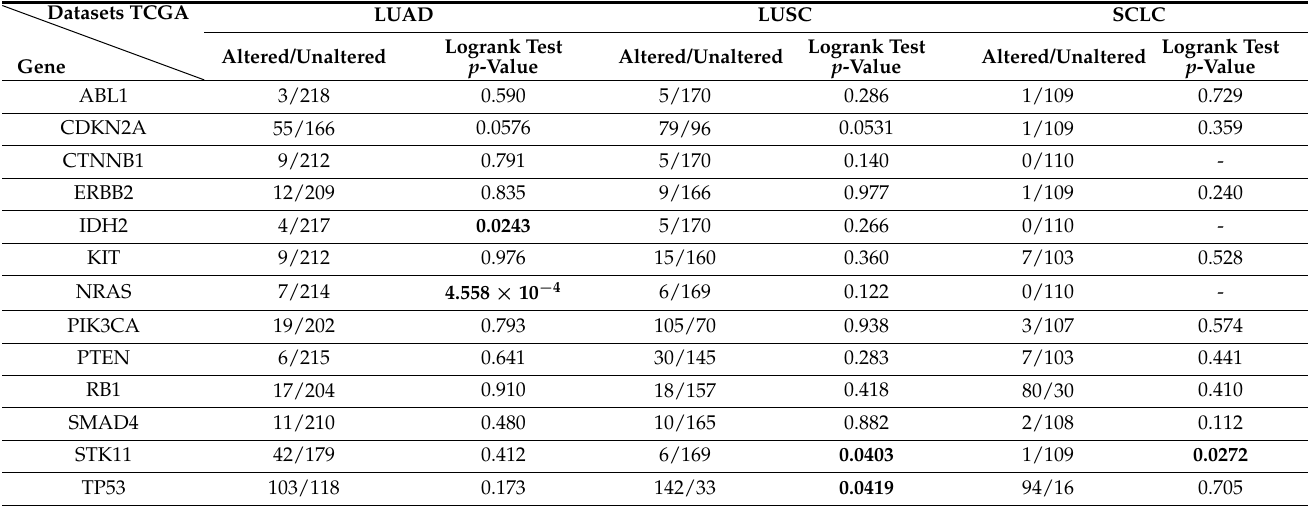
Table 4. Overall patient survival status in the TCGA lung cancer